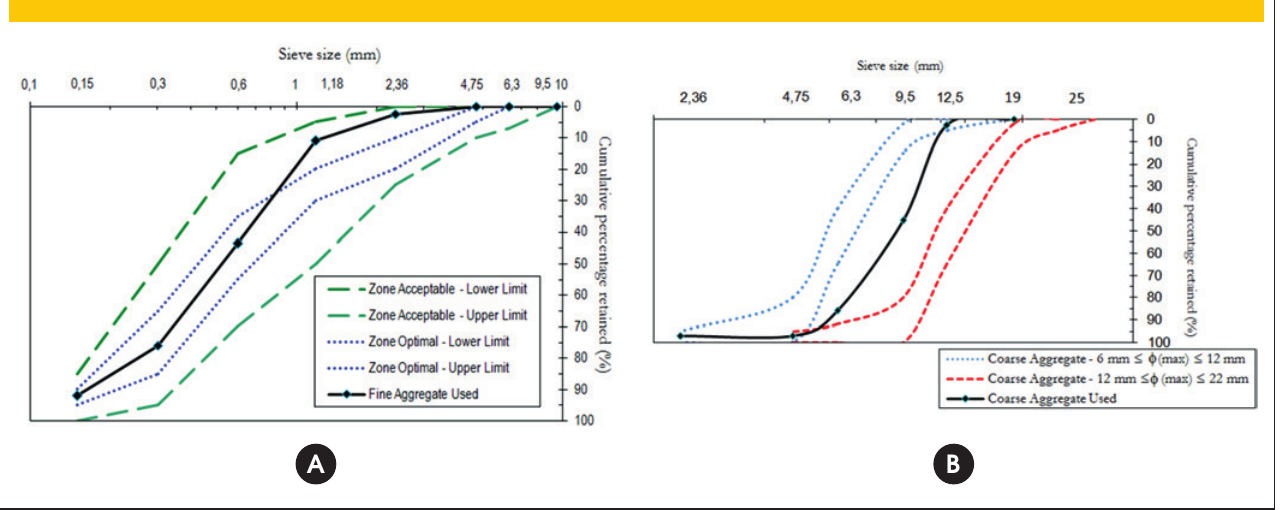
Figure 4 – Grading curve for (a) fine aggregate, (b) coarse aggregate